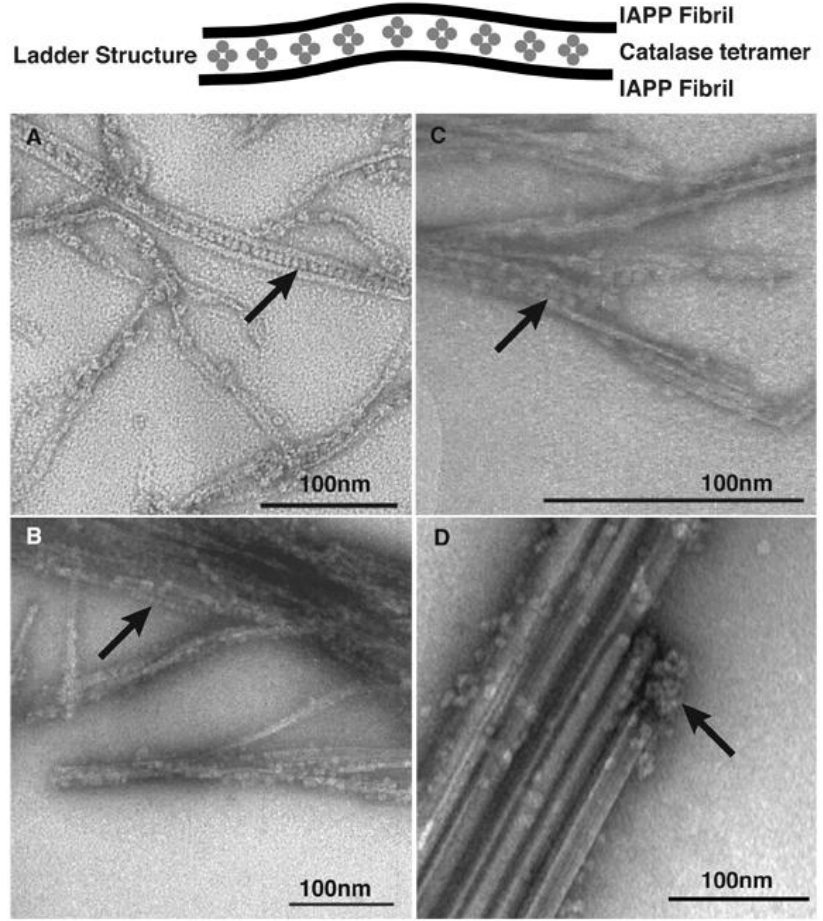
FIGURE 2 . Catalase binding to human IAPP fibrils — 1-37 (A), 8-37 (B and C), and 20-29 (D) — all showed catalase binding (example indicated by arrow in A–C). There was also cross-linking of two fibrils by a chain of HEC molecules in the 1-37 (A) and 8-37 (C) samples in a manner detailed in the schematic diagram. The HEC aggregates were observed in the 20-29 (D) sample (arrow). The scale bars indicate 100